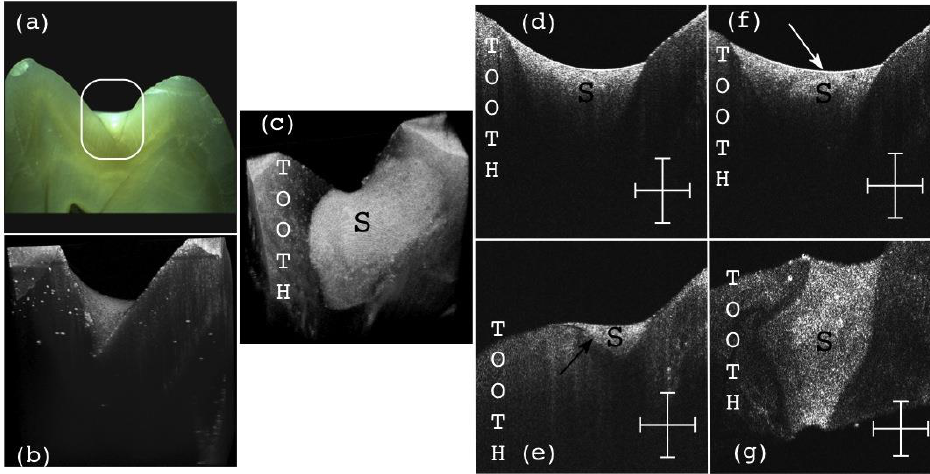
Figure 19. OCT B-scan of a treated dental cavity: ( a ) area of interest; ( b ) 3D OCT reconstruction after the investigation showing the mentioned area; ( c ) general aspect of the sealant (S) from the occlusal view; ( d ) B–scan of the structure presenting a good interface between the tooth enamel and the sealant (S); ( e ) B–scan presenting an open interface (black arrow) between the sealant (S) and the tooth structure; ( f ) B–scan presenting a defect (white arrow) inside of the sealant material; ( g ) C–scan of the structure presenting no defects inside the sealant (S) material at the considered depth;. Scale bars: 1